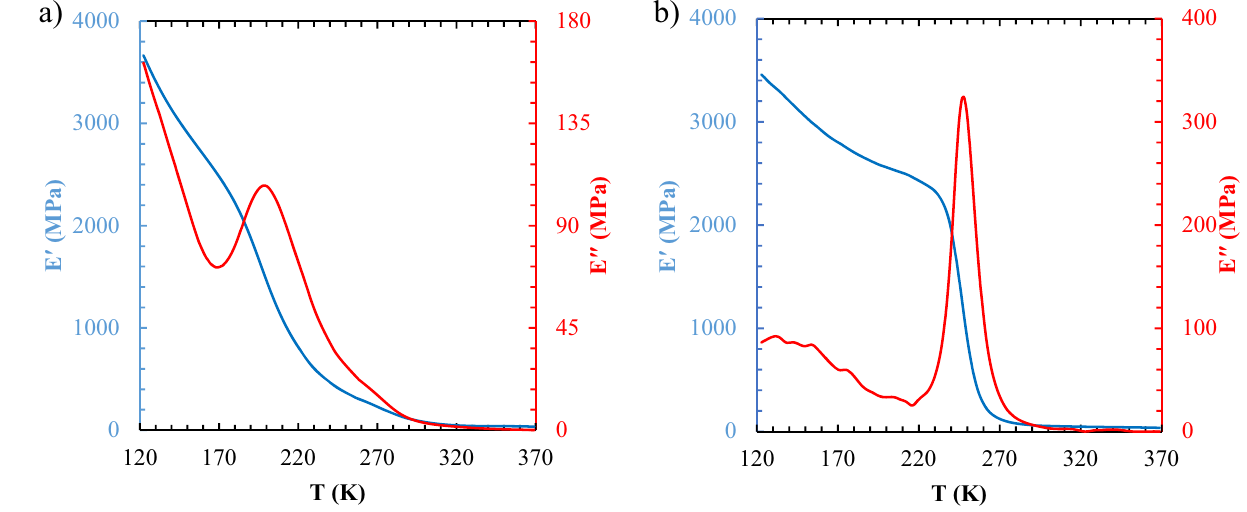
Figure 6. The DMTA analysis of: ( a ) TPU-1 and ( b ) TPU-3 based on tensile mode at a frequency of 1